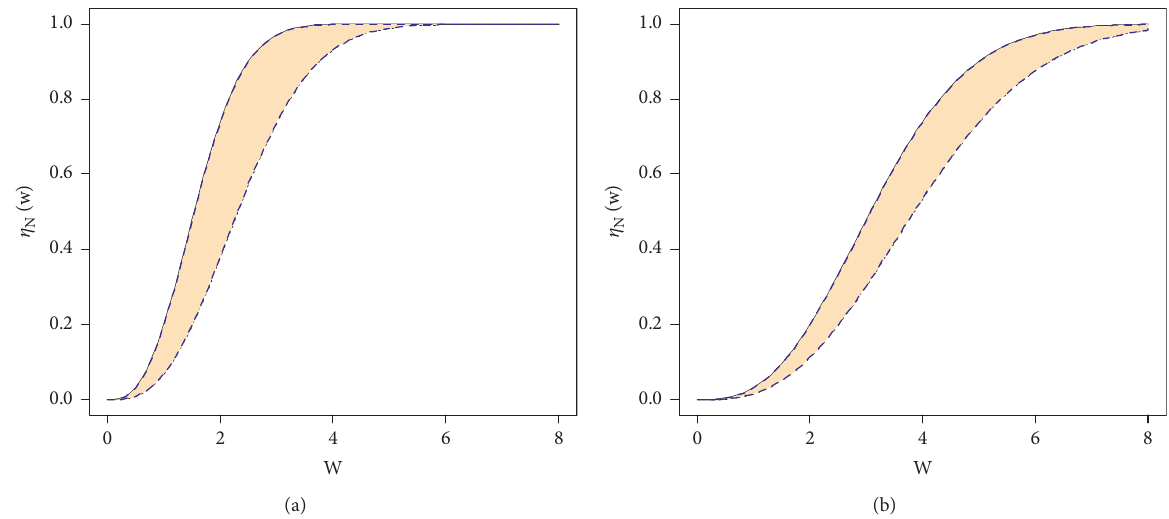
Figure 2: Neutrosophic distribution function curves of the Maxwell model with different values of λ